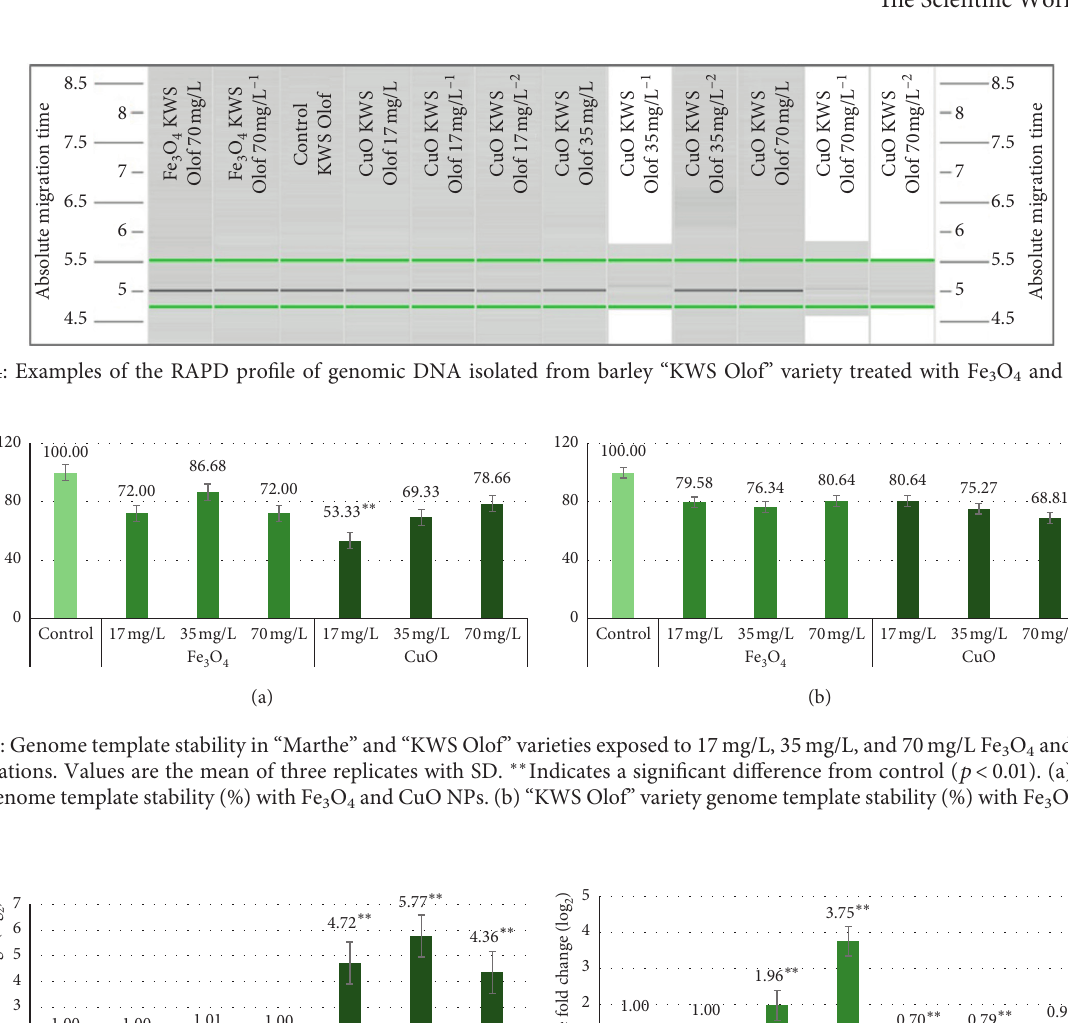
Figure 6: Average fold changes of the miR156a expression level in “Marthe” and “KWS Olof” variety grown with different con- centrations of Fe 3 O 4 and CuO NPs. Values are the mean of three replicates with SD. ∗∗ Indicates a significant difference from control ( p < 0.01). (a) miR156a expression level in “Marthe” variety with Fe 3 O 4 and CuO NPs. (b) miR156a expression level in “KWS Olof” variety with Fe 3 O 4 and CuO NPs.